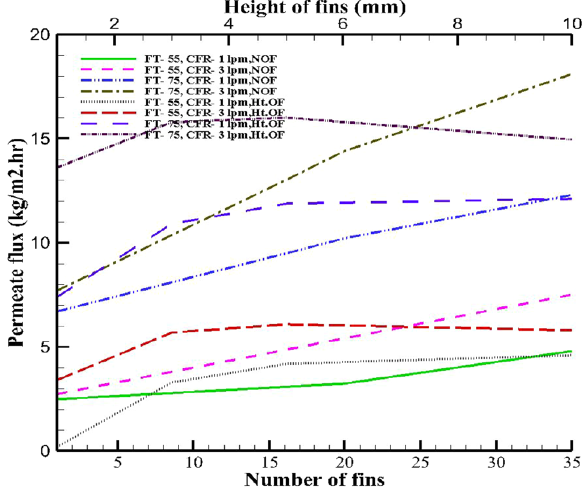
Fig. 13 Effect of number of fins and height of the fins on permeate flux for different values of feed temperature and cold flow